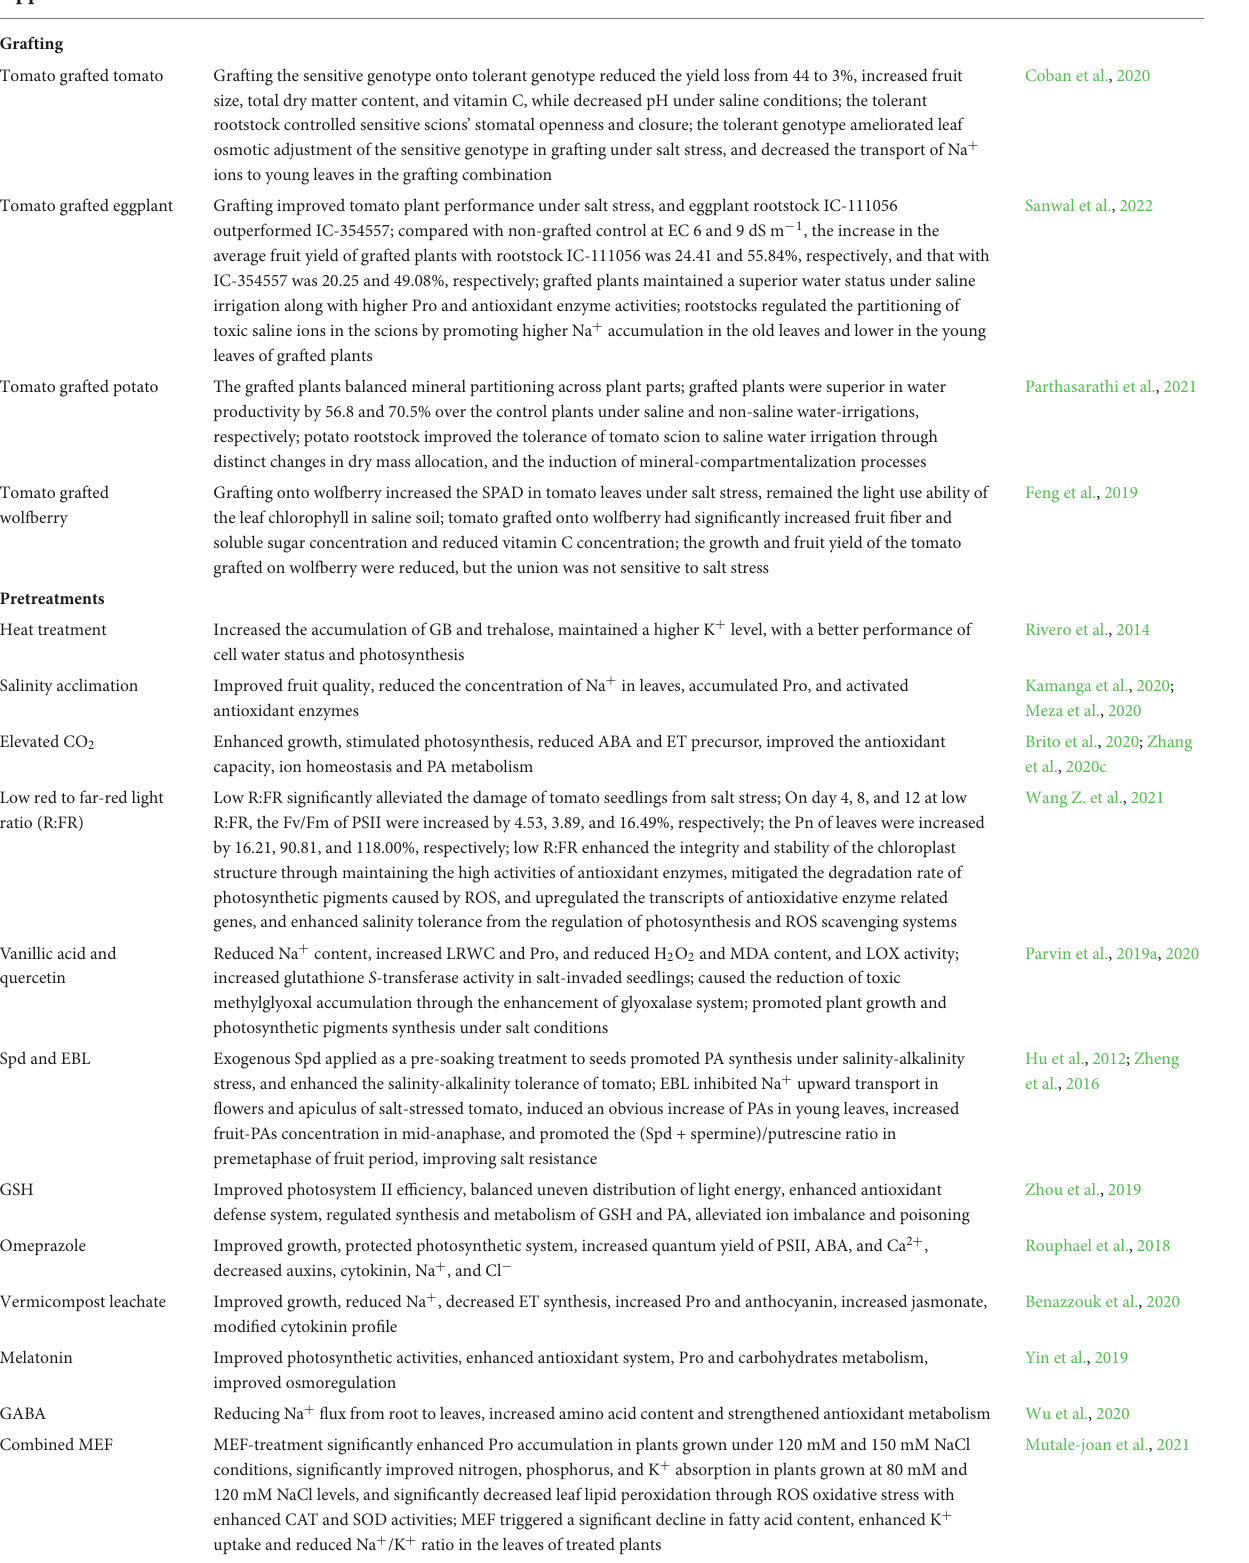
TABLE 2 Summary of eco-sustainable approaches to improve salt tolerance in tomato. Approach